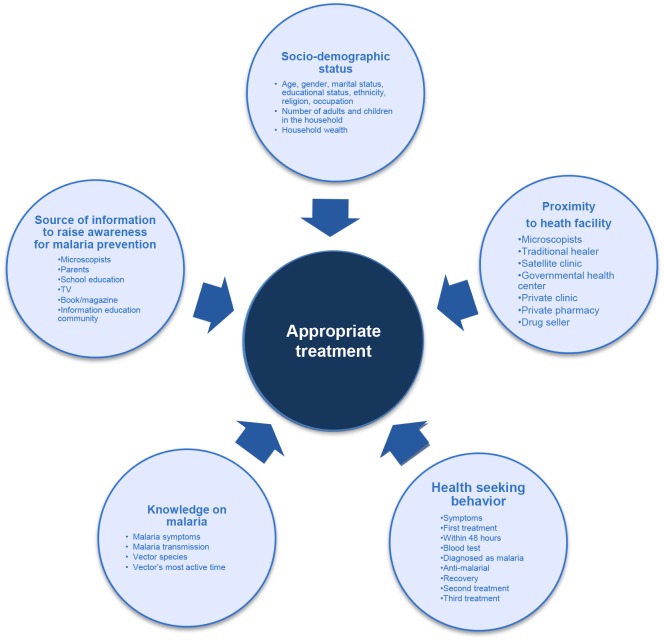
Conceptual framework.The authors hypothesize that an association exists between “appropriate treatment” and the following multi-directional variables: “socio-demographic status,” “proximity to health facility,” knowledge on malaria,” and “participation in community awareness-raising activities for malaria prevention.” Sub-variables of each variable are in the circles of the conceptual framework.